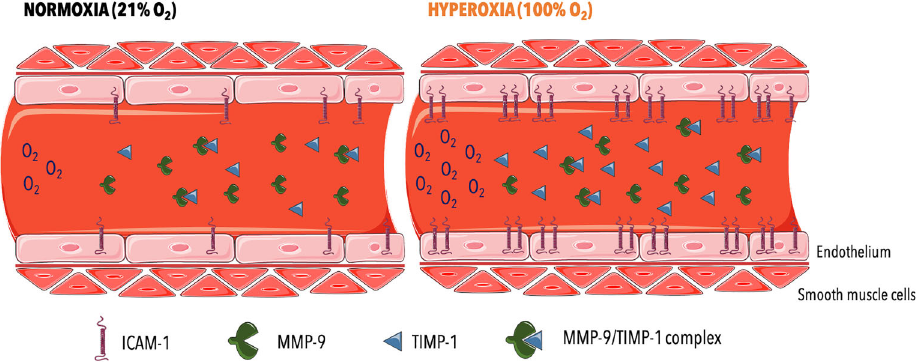
Figure 3. Hyperoxia induces activation of the endothelium via increased ICAM-1 expression and stimulates the extracellular matrix dysregulation characterized by increased TIMP-1 levels and reduced MMP-9 activity. ICAM-1: intercellular adhesion molecule 1; MMP-9: matrix metalloproteinase-9; TIMP-1: tissue inhibitor of metalloproteinase